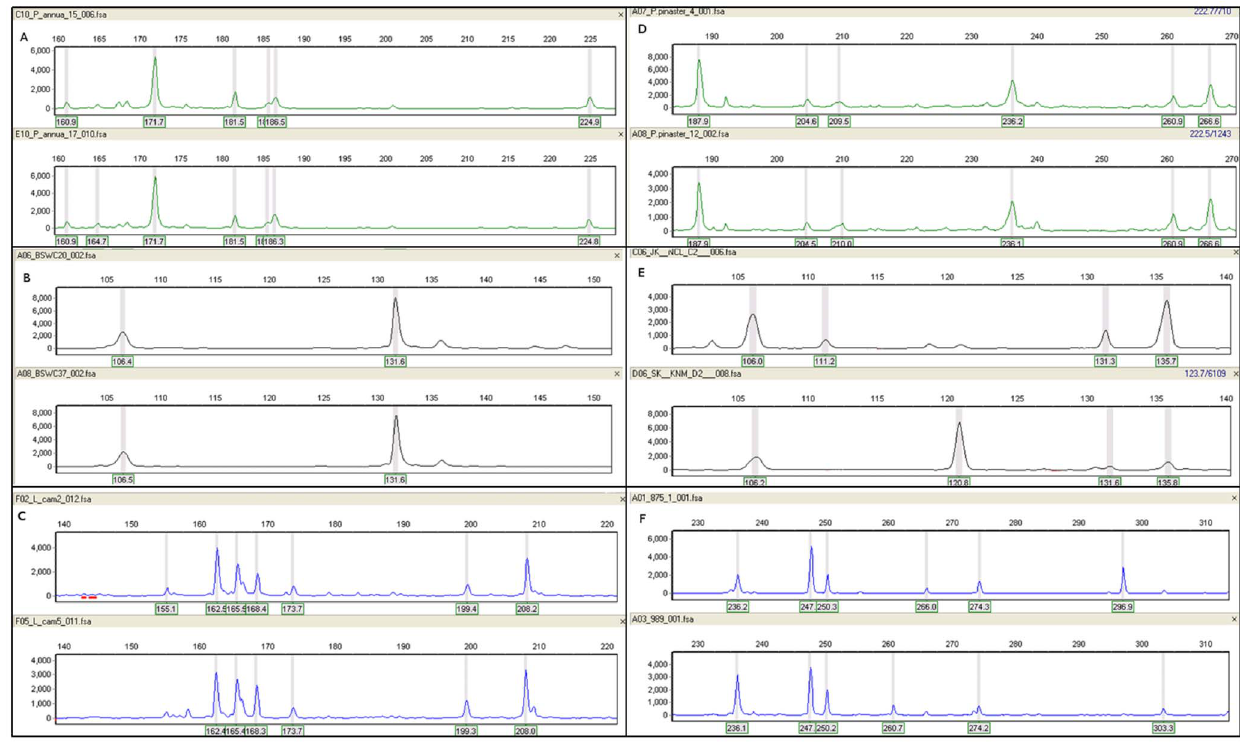
Figure 1. Typical fingerprint profiles generated with the primer pairs: EcoR I-ATG- Hex TM + Mse-CTT for A) two Poaannua samples and D) 2 Pinuspinaster samples; B) EcoR I-AAT-Ned + Mse-CTT for two Pennisetumsetaceum and E) two Bassiadiffusa samples samples; and EcoR I-CAT-FAM + Mse-CTT for C) two Lantanacamara samples, and F) two Salvia spp. samples.